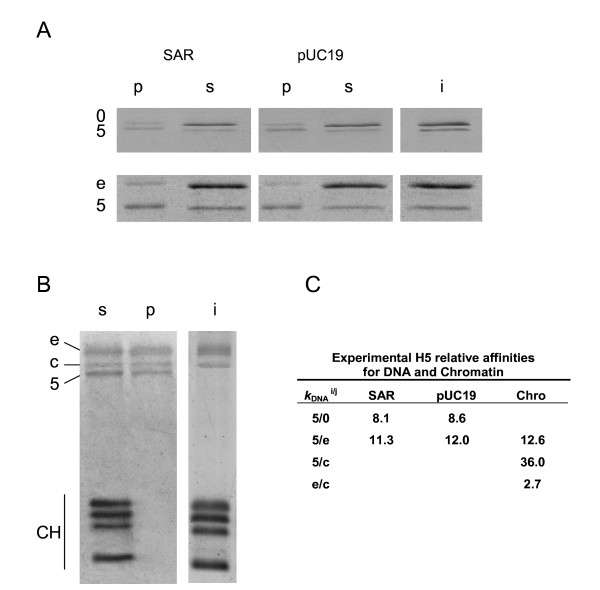
Affinity of avian H5 for DNA and chromatin. (A) Competition between H5 and H1° or H1e for a limited amount of SAR and pUC19 DNA. (B) Perturbation of H1 complement of native chromatin with H5. (C) Experimental H5 relative affinities for SAR and pUC19 DNA and chromatin. The number is the average of three independent experiments. p, pellet; s, supernatant; i, input; Chro, chromatin; 0, H1°; 5, H5; e, H1e; c, H1c; CH, core histones.